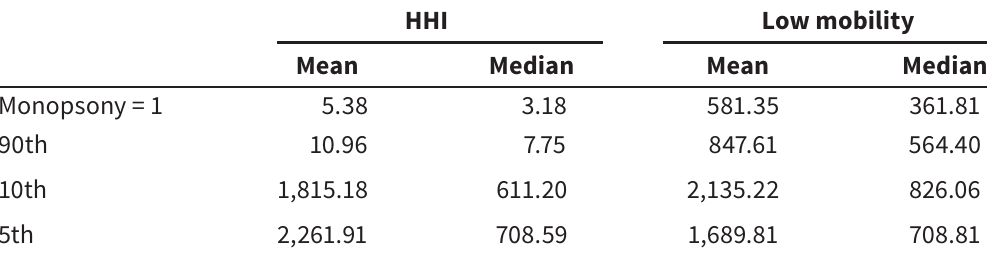
Average number of establishments by